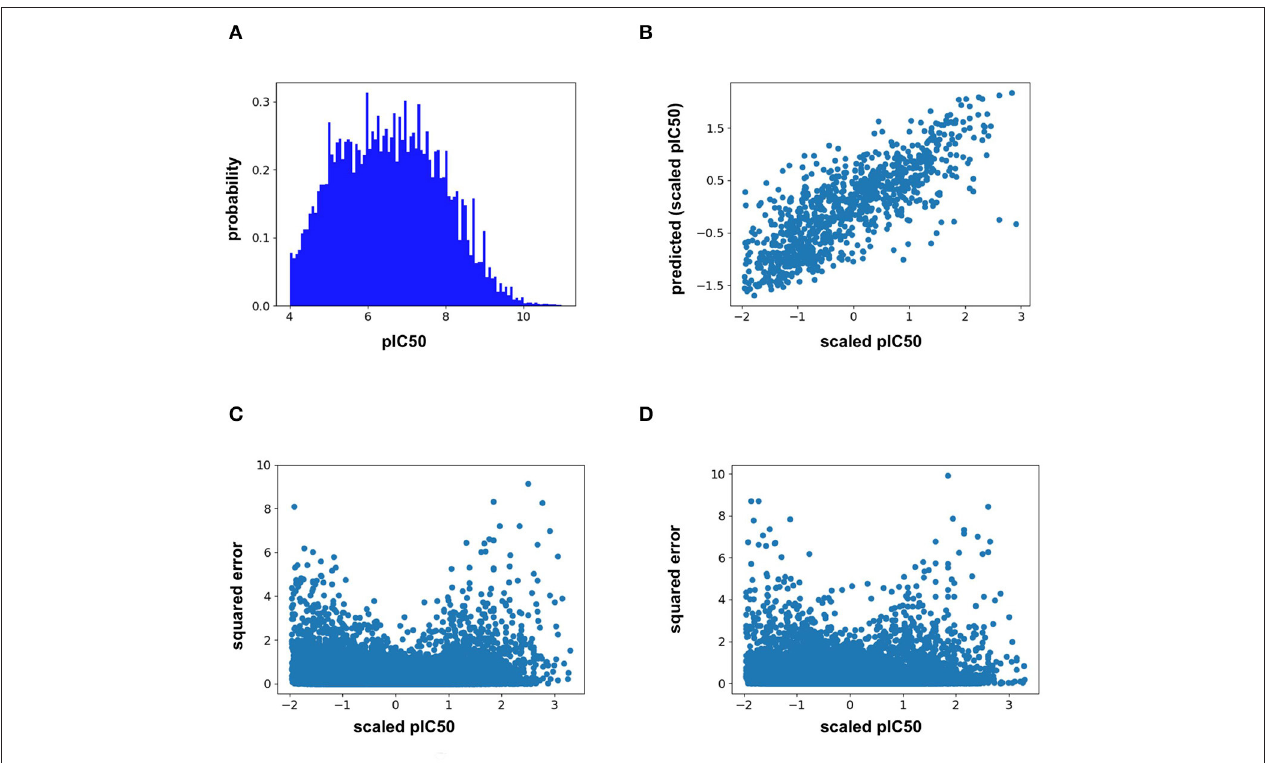
and bias between the training and validation set are the most import variables determining